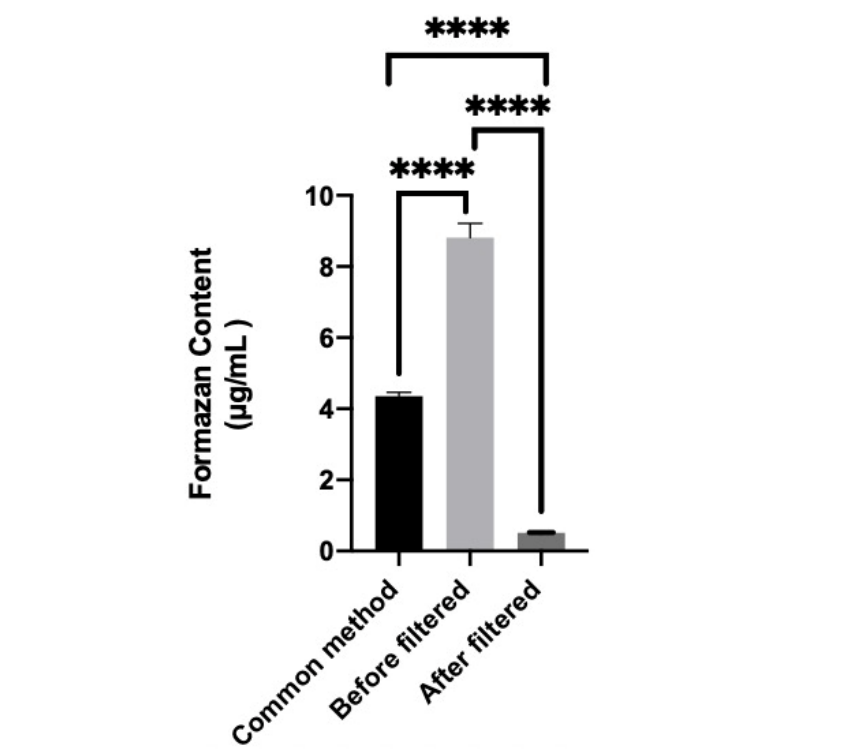
Figure 4. The final formazan content of NZ ‘Hass’ ripe avocado seed extract treated in the S. aureus suspension (RSE-formazan) using three dissolving methods. Common method: acidic isopropanol dissolving method; before filtering: isopropanol dissolving method; after filtering: after column chromatography filtering method. Results are expressed as the mean ± SD. Quadruple asterisks (****) indicate p < 0.0001. ns indicates p > 0.05.